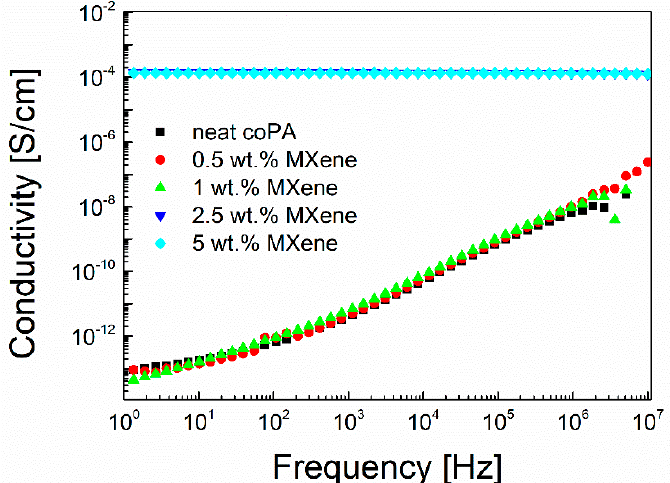
Figure 2. Electrical conductivity of electrospun coPA filled with Ti 3 C 2 T x.